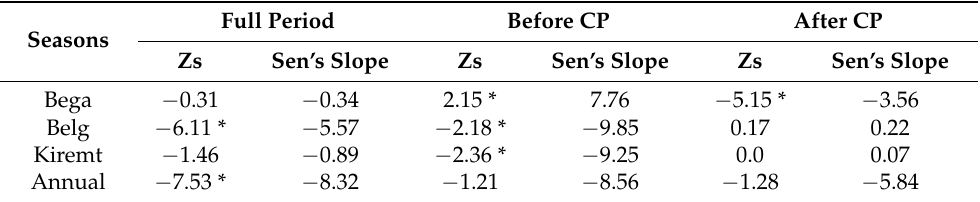
Table 6. The M–K test and Sen’s slope results of seasonal and annual rainfall before the changing point (1986–1997), after the changing point (1998–2015), and full study period (1986–2015). Full Period Before CP After CP Seasons Zs Sen’s Slope Zs Sen’s Slope Zs Sen’s Slope